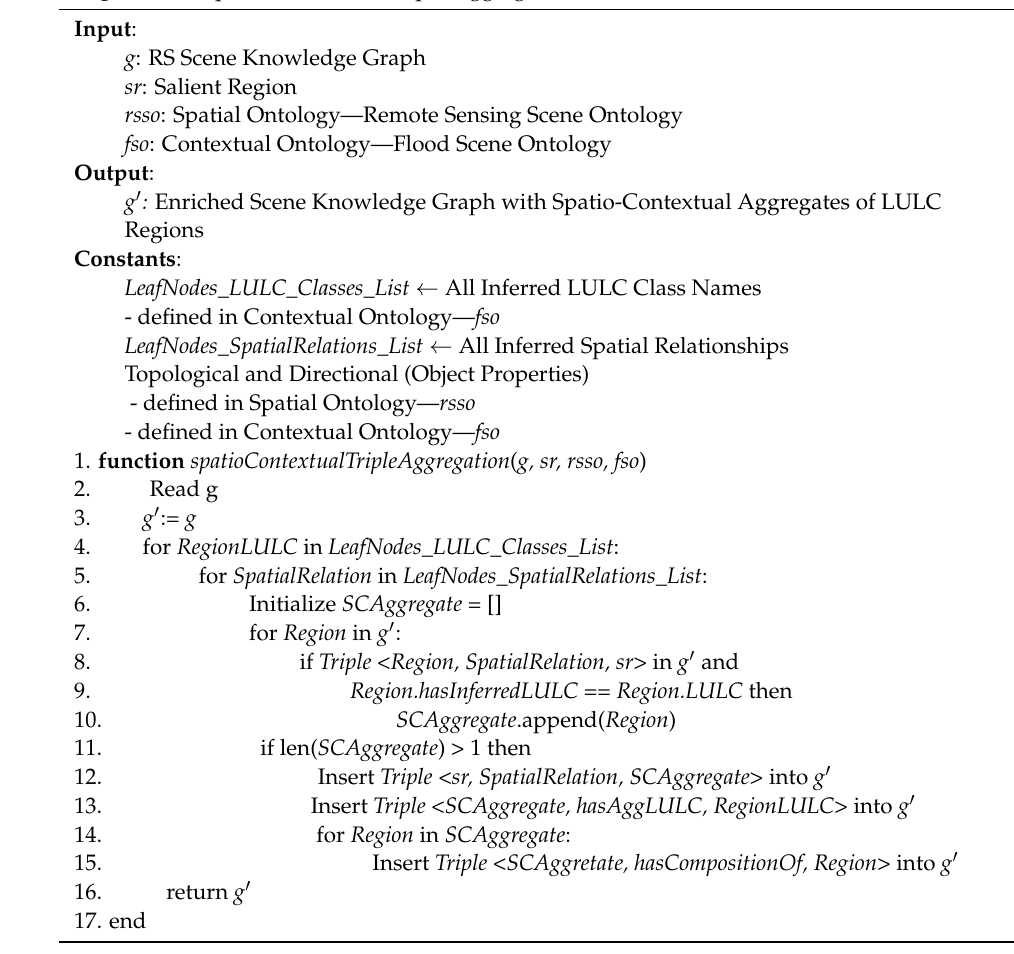
Algorithm 2 Spatio-Contextual Triple